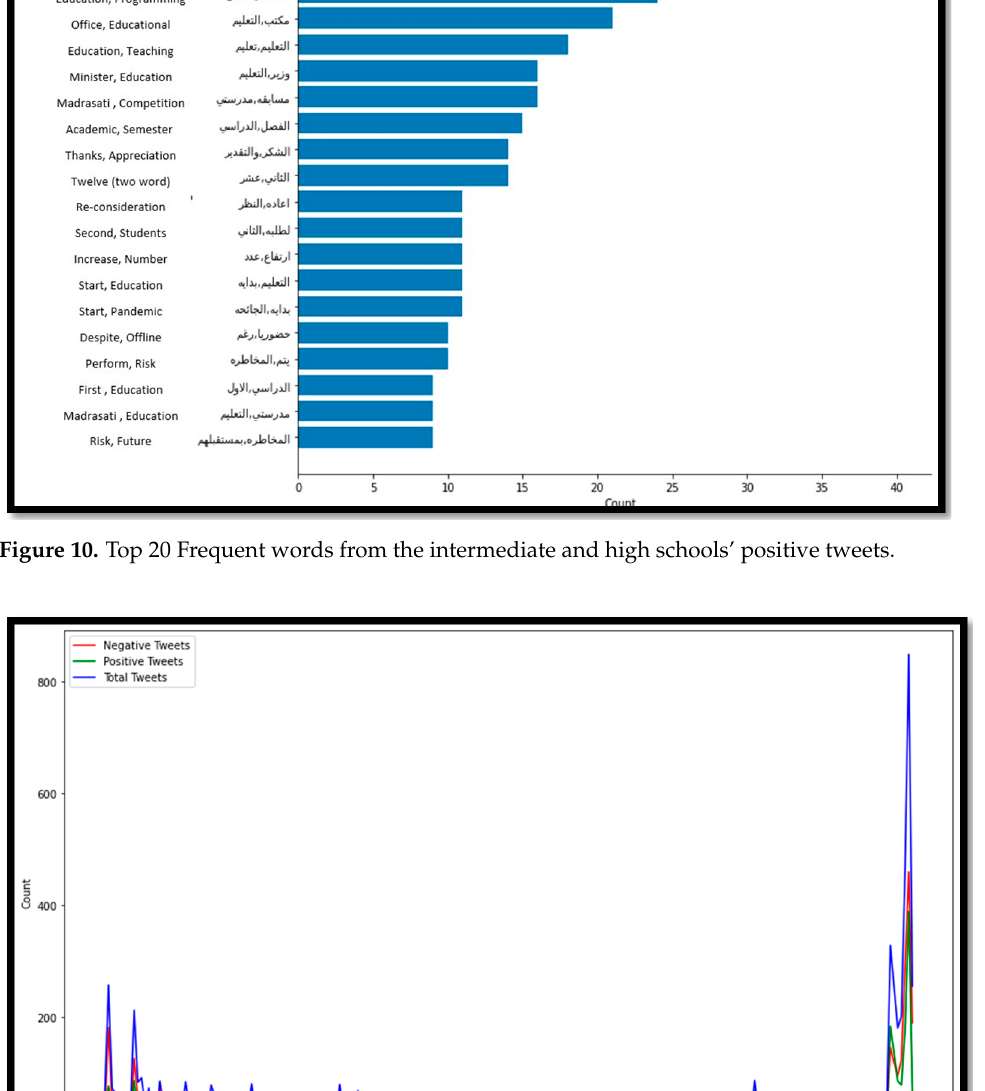
Figure 11. Time series analysis of all tweets in application dataset.